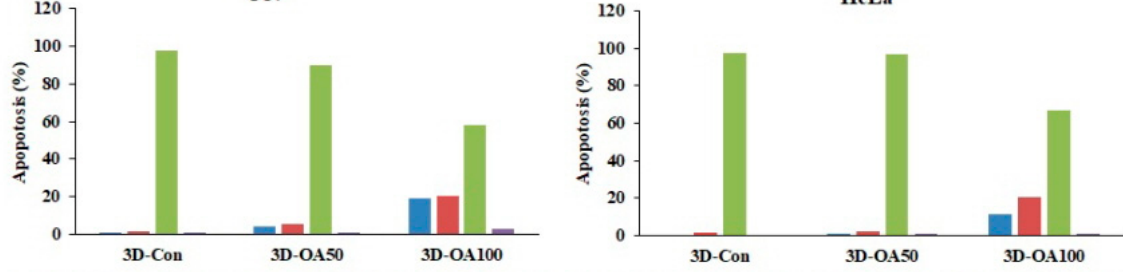
Figure 7. ( A ) Determination of the apoptotic populations of normal cells (BNL-CL2 and L-132 cells) and cancer cells (U87 and HeLa cells) Annexin V-fluorescein isothiocyanate (FITC)/propidium iodide (PI) staining and subjecting to flow cytometry in polydimethylsiloxane (PDMS) multi-channel cell chip. The cells were cultured at 1 × 10 5 cells/mL and treated with oleanolic acid (OA; 50 and 100 µg/mL) for 24 h. ( B ) Quantitation of the data shown in ( A ).